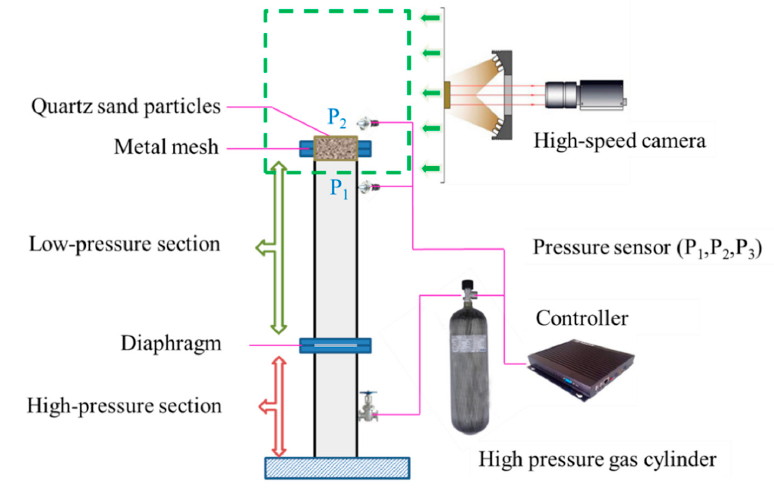
Figure 1. Schematic diagram of the self-designed vertical shock tube generator.